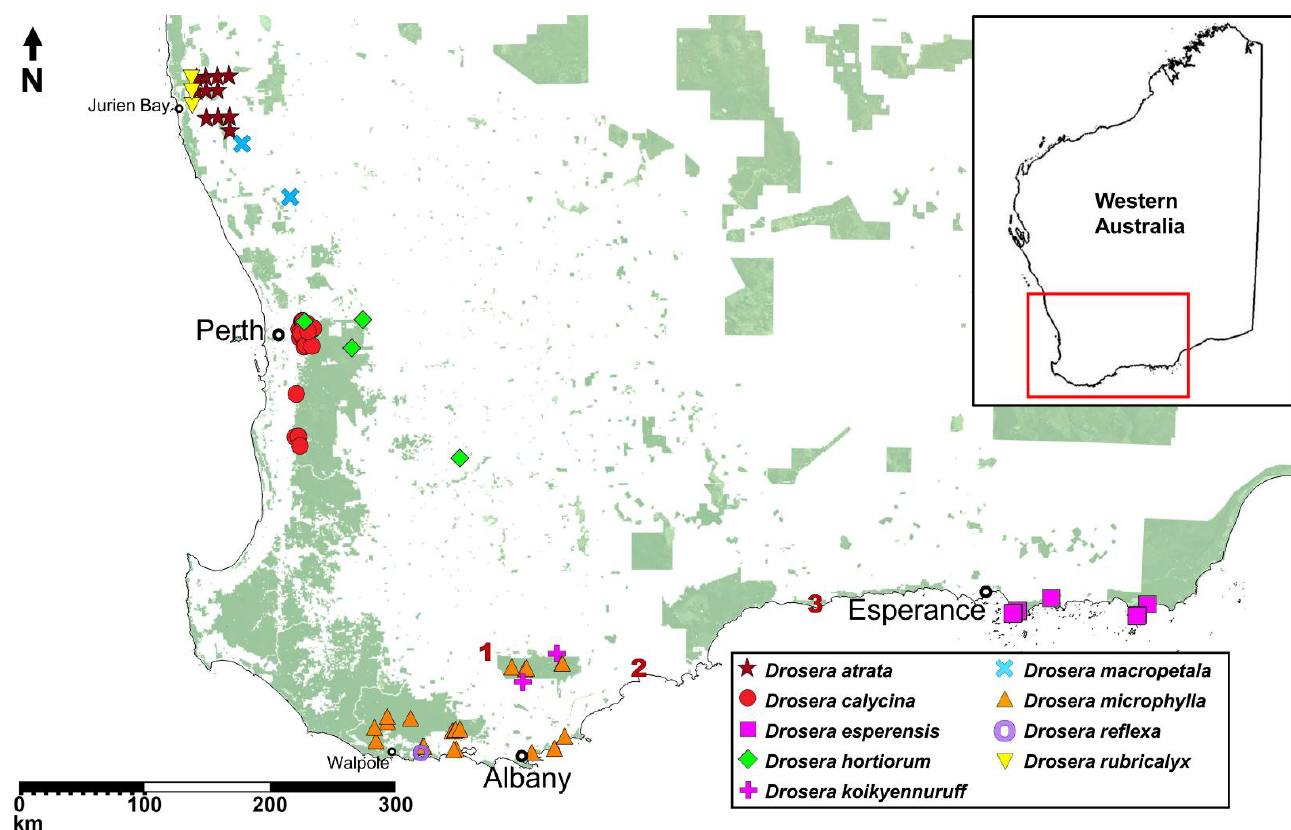
Figure 3. Map showing the known localities of all nine species of the Drosera microphylla complex based on herbarium records and field observations by the authors. Locality coordinates of species recommended for inclusion on the Priority Flora List under the Conservation Codes for Western Australian Flora and Fauna have been generalised to the nearest 0.1 degrees. Numbers 1–3 indicate localities of potential undescribed taxa discussed in the Taxonomic notes sections of D. koikyennuruff and D. microphylla . Background map illustrates protected conservation lands managed by the Department of Biodiversity, Conservation and Attractions (DBCA).